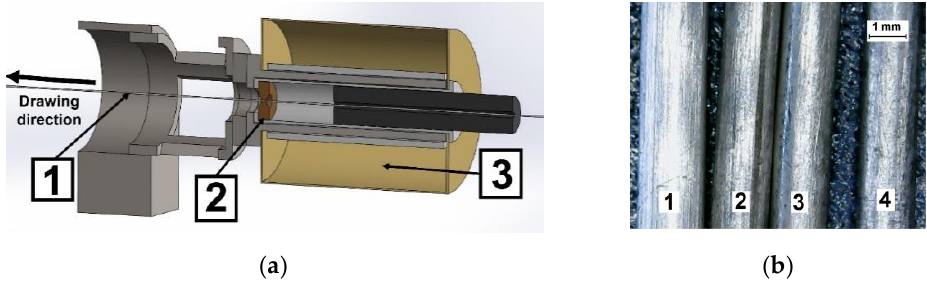
Figure 1. Technology of wire production: ( a ) hot-drawing processes used in the experiment: 1—wire; 2—drawing die; 3—heating device; ( b ) wires, obtained by extrusion (1), hot drawing in temperature conditions t350 (2), t400 (3), and t440 (4).